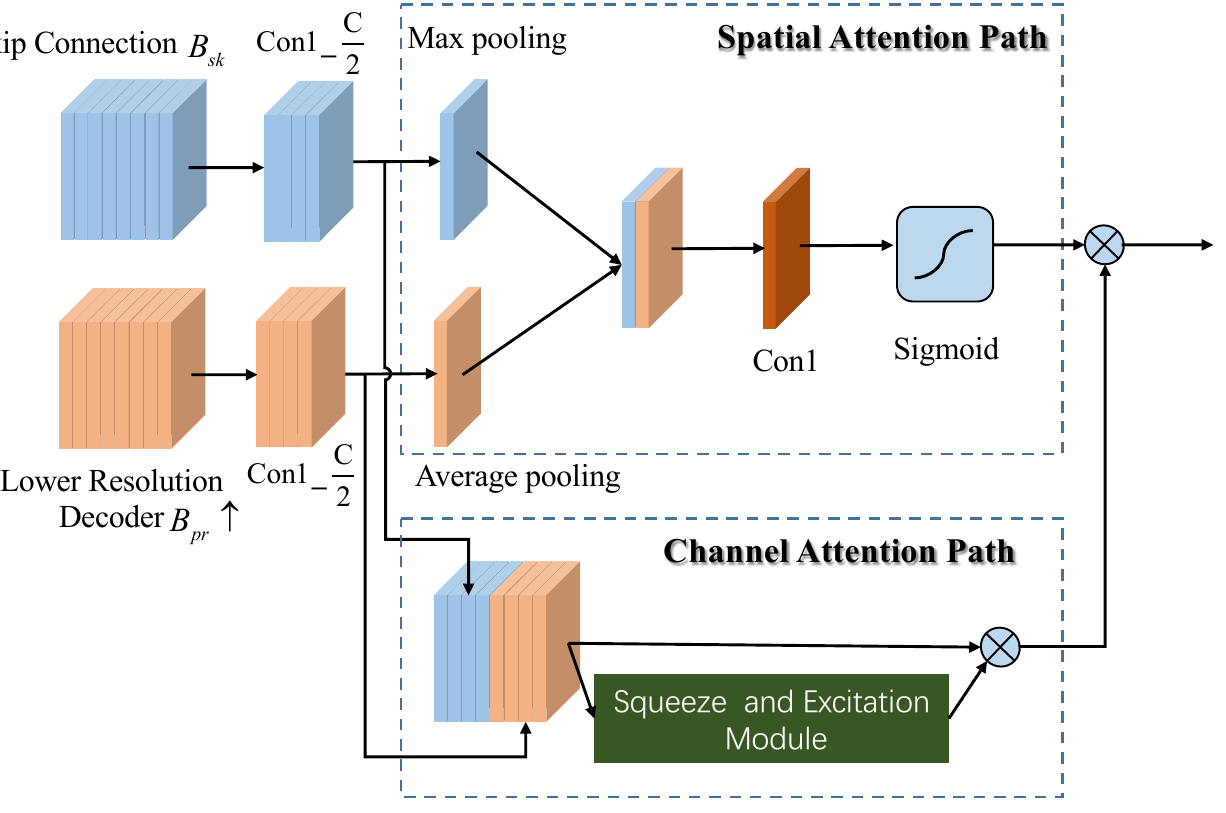
Figure 2. The flowchart of dual-path attention